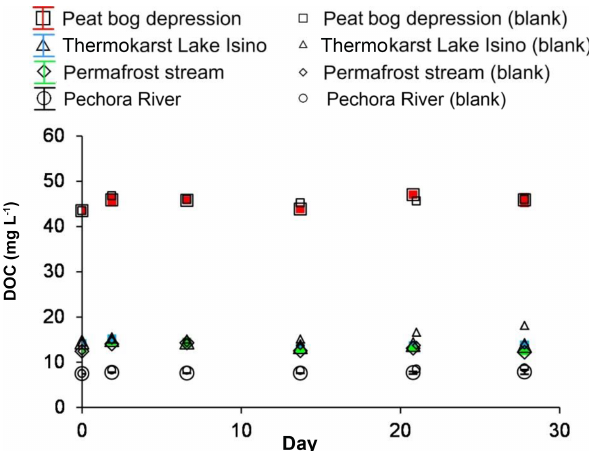
Figure 1. The DOC concentration over time in the biodegradation experiments at 23 ◦ C. The experiments are shown using solid sym- bols and the control runs are shown using open symbols: red squares represent peat bog depression, green diamonds represent permafrost stream, blue triangles, represent thermokarst Lake Isino and black circles represent the Pechora River. The error bars represent ± 1SD of the three replicates and are often within the symbol